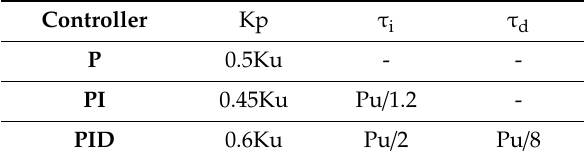
Table 2. Controller parameters for the closed loop Ziegler–Nichols method.